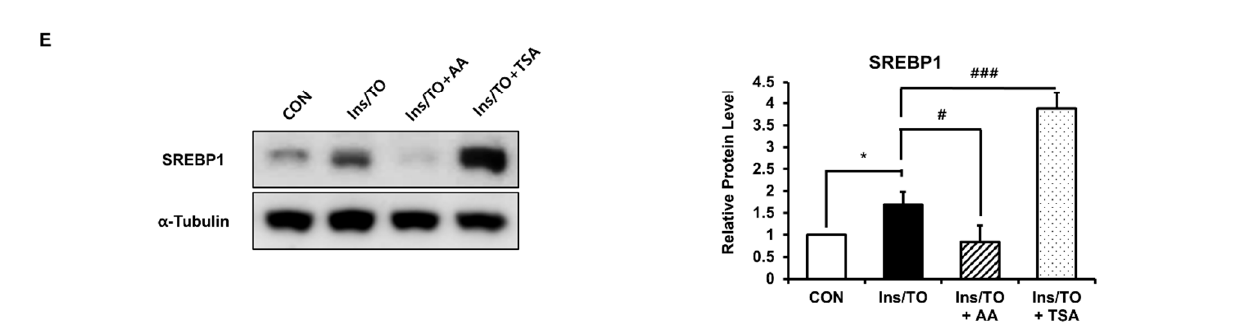
Figure 2. The p300 histone acetyltransferase (HAT) inhibitor anacardic acid (AA) inhibited lipogenesis through SREBP1 induction, whereas the histone deacetylase (HDAC) inhibitor trichostatin A (TSA) stimulated it. SZ95 cells were treated with 12.5 µM AA or 0.2 µM TSA in addition to insulin and liver X receptor (LXR) agonist TO901317 treatment (Ins/TO) for 48 h or 72 h. ( A ) After 72 h, Oil Red O staining was performed to analyze the amount of lipid droplets (left). Scale bar = 100 µm. Quantitative analysis of Oil Red O was performed using the Image J software. After Oil Red O staining, the lipid content was eluted into isopropanol, and the optical density at 500 nm was determined using a microplate reader. Values represent the mean ± SD from three independent experiments. * p < 0.05, ** p < 0.01 vs. control; # p < 0.05, ## p < 0.01, ### p < 0.001 vs. SZ95 cells treated with Ins/TO. ( B – D ) The expression of sterol regulatory element binding protein 1c (SREBP- 1c), FAS, and ACC α mRNA was quantified by real-time PCR 48 h after AA or TSA treatment and normalized to the respective 36B4 as a control. Values represent the mean ± SD from three independent experiments. * p < 0.05 vs. control; # p < 0.05, ## p < 0.01 vs. SZ95 cells treated with Ins/TO. ( E ) SREBP1 protein expression was measured 48 h after treatment by Western blotting. Bar graphs show densitometric quantitation of SREBP1 as ratios to α -Tubulin, which was used as the loading control. Data represent the mean ± SD of four independent experiments ( n = 4). * p < 0.05 vs. control; # p < 0.05, ### p < 0.001 vs. sebocytes treated with Ins/TO.